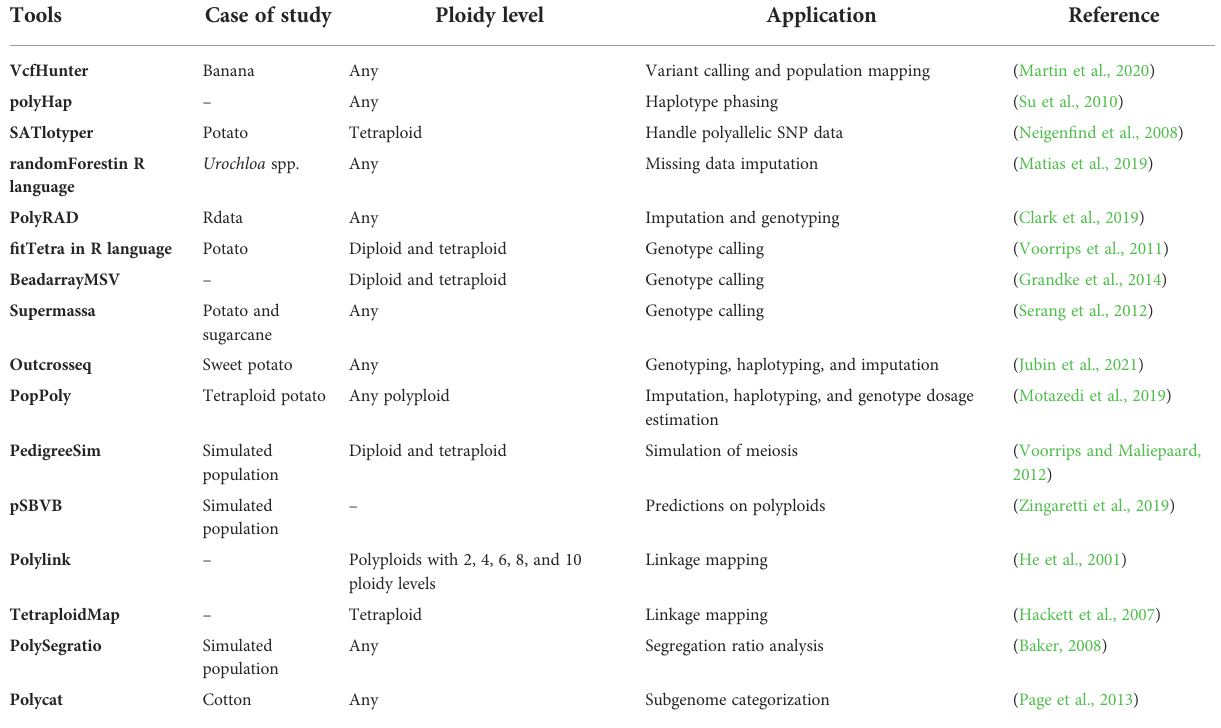
TABLE 1 Overview of different bioinformatics programs and packages used for genomic in